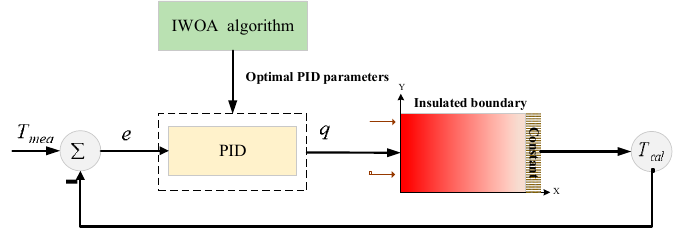
Figure 2. Schematic diagram of the heat flux inverse estimation by IWOA-PID.